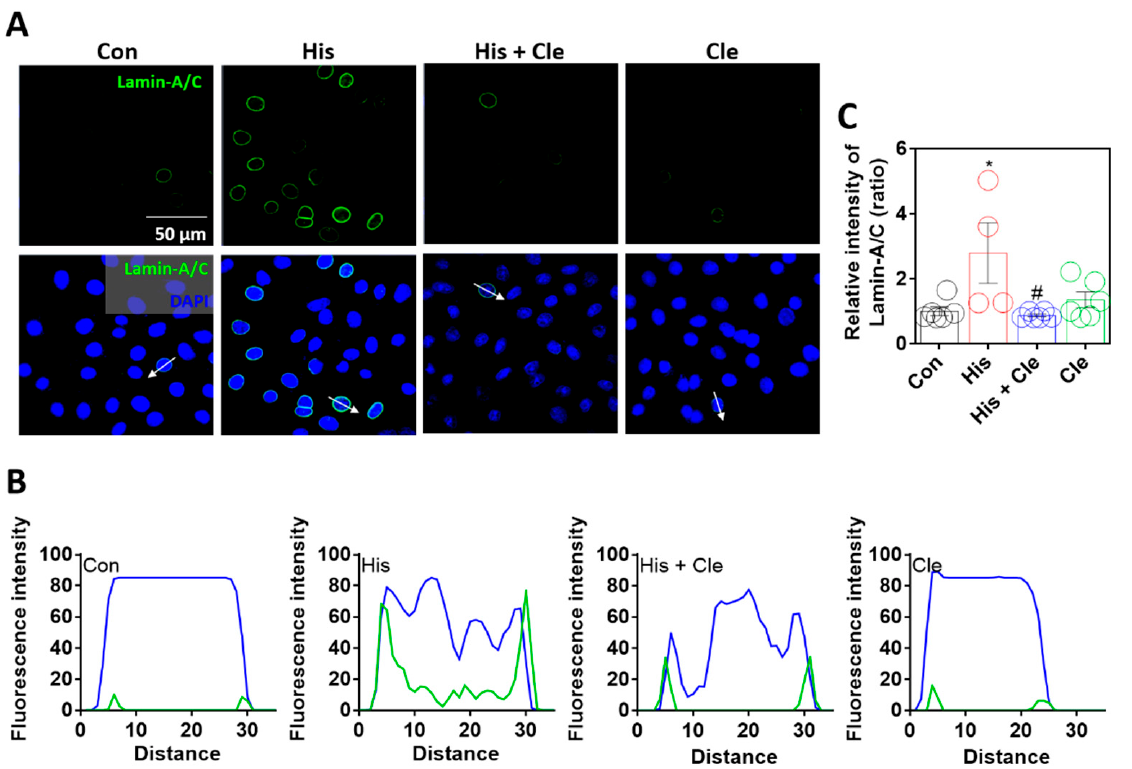
Figure 2. Lamin-A/C expression was dependent on histamine-mediated signaling. ( A ) Immunofluorescence staining of lamin-A/C (green) and DAPI (blue) after histamine (His) treatment (100 µ M, 24 h) with or without clemastine (Cle; 10 µ M, 24 h) in A549 cells. Scale bars represent 50 µ m. Lower panels were merged images. ( B ) Fluorescence intensity in the sectional distance of cells indicated by white arrows. Green and blue lines indicated lamin-A/C and DAPI, respectively. ( C ) The graph indicates relative intensity of lamin-A/C. The bars present the mean ± SEM ( n = 4~6, * p < 0.05 vs. control and # p < 0.05 vs. His-treated group).